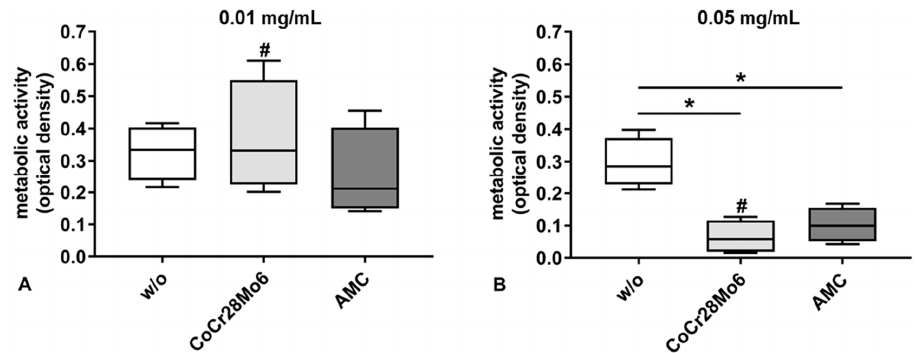
Figure 2. Cell viability of human primary fibroblasts after exposure to CoCr28Mo6 and AMC particles using concentrations of 0.01 mg/mL ( A ) and 0.05 mg/mL ( B ). Cells were transferred into standard culture plates allowing adherence over 24 h. Afterwards, the cell culture medium was replaced by different concentrations of particles and EtOH (control). After 48 h the metabolic activity was determined by the WST-1 assay. Data are shown as box plots ( n = 4). Differences between groups were calculated with the Mann-Whitney- U -Test (* p < 0.05, treated vs. untreated; # p < 0.05, 0.05 mg/mL vs. 0.01 mg/mL).